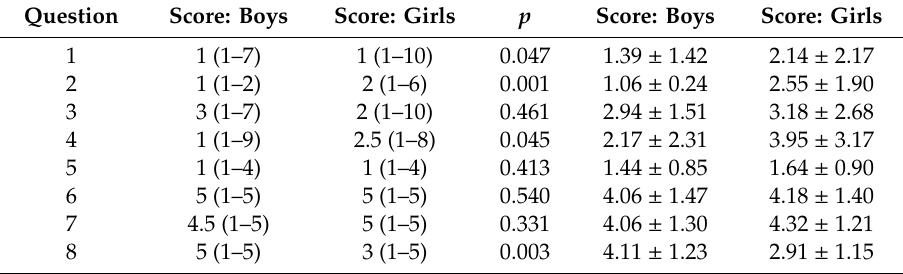
Table 1. Answer scores for both groups presented as the median value (range) and p (Mann − Whitney U-testwithcontinuitycorrection); scoresforeachquestionforbothgroupspresentedasmeanvalue ± SD. Question Score: Boys Score: Girls Score: